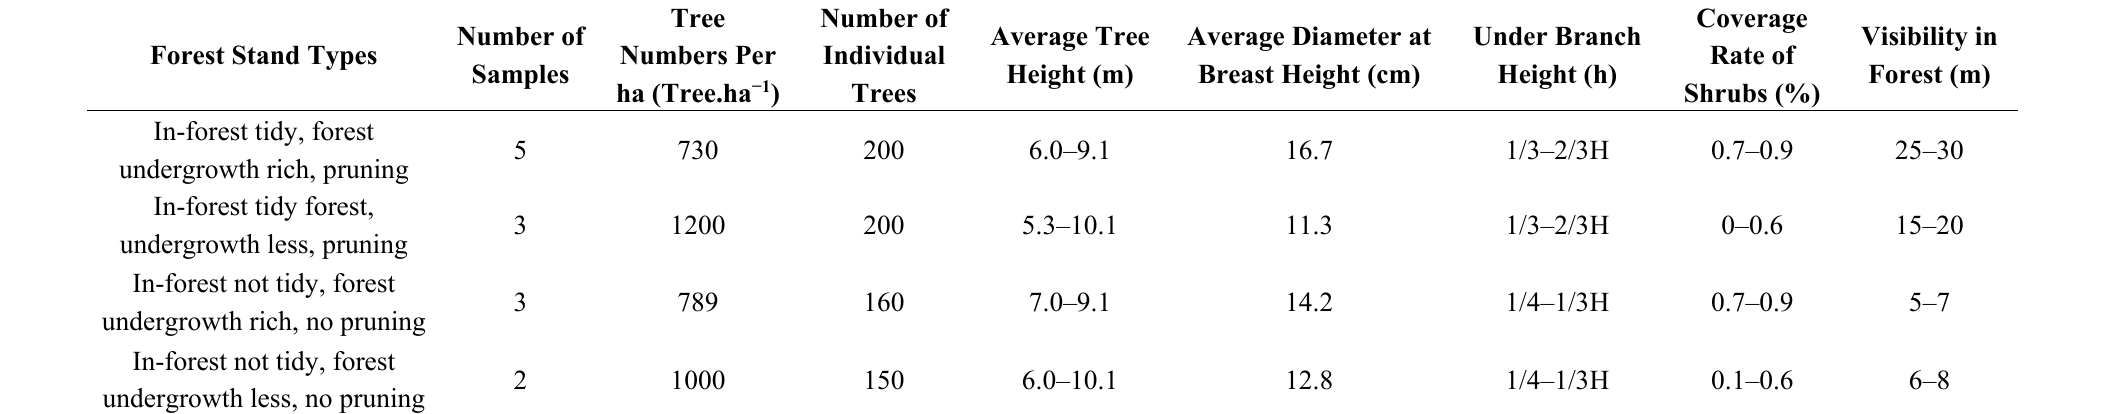
Table 1. Stand description and attributes of main trees within